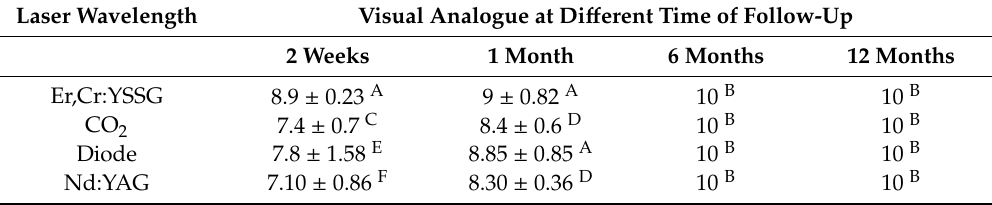
Table 6. Visual analogue scale of patient satisfaction at di ff erent